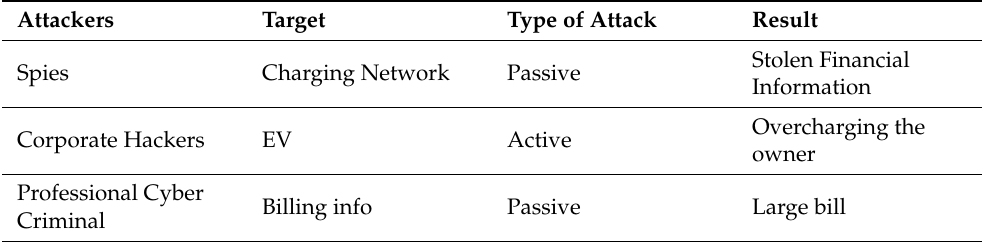
Table 5. The Threats in Charging